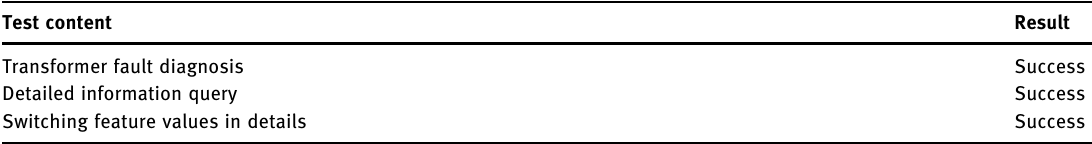
Table 3: Analysis of diagnostic function test